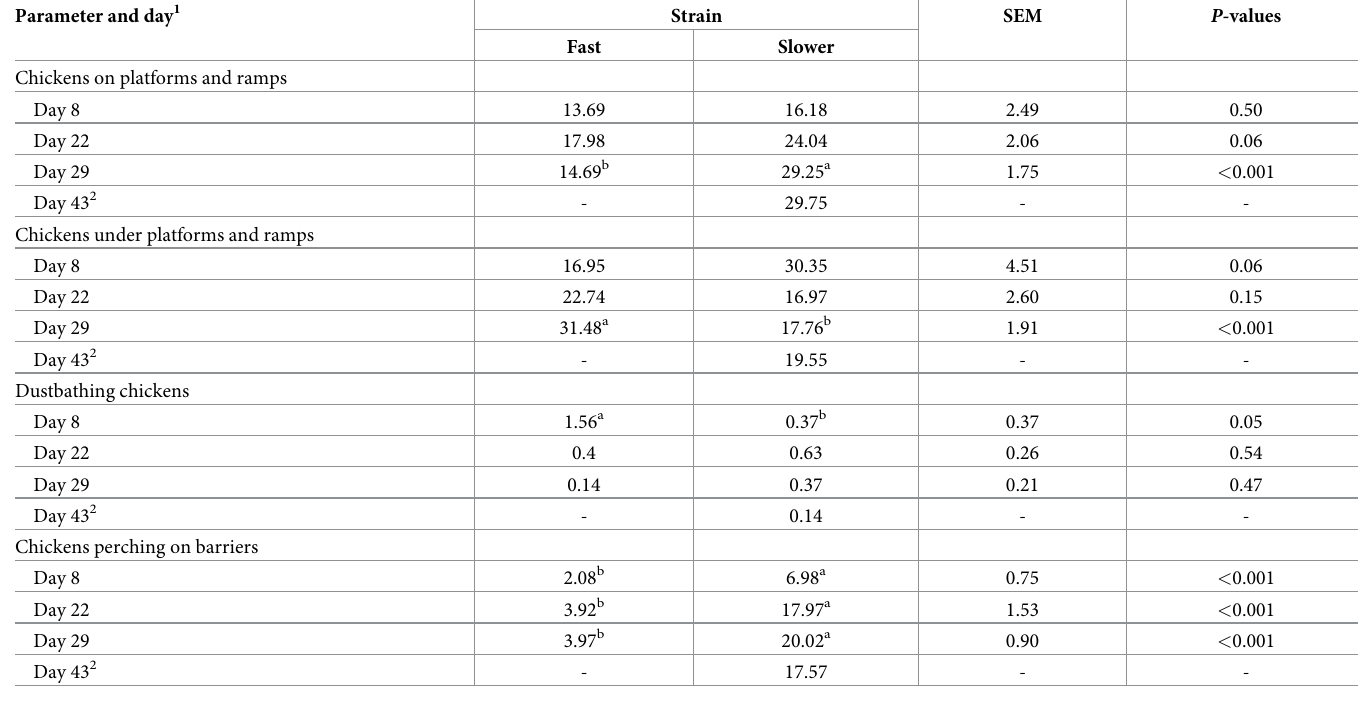
Table 7. Effects of broiler strain (fast-growing ross 308 or slower-growing Hubbard JA 757) on percentage of male chickens in enriched pens, using the following enrichment objects (on platforms and ramps, under platforms and ramps, dustbathing, perching on barriers) at day 8, 22, 29 and 43 of age (n = 7 pens per treat- ment, LSmeans ±